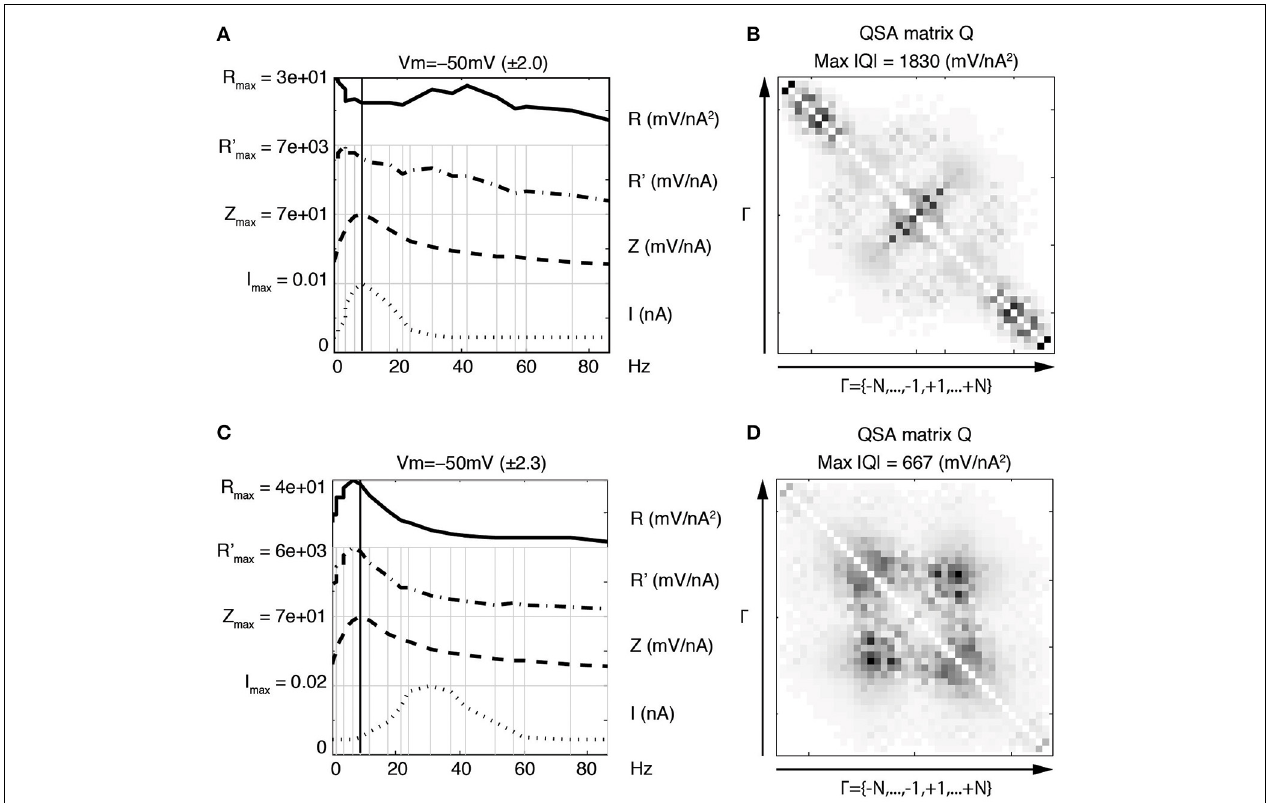
FIGURE 8 | Nonlinear effects of a Gaussian-like window applied to the stimulation Fourier components. Upper row (A,B) Gaussian-like window applied to the stimulation Fourier components near the resonance f 8 = 8 . 7Hz. This induces enhanced frequency interactions between input